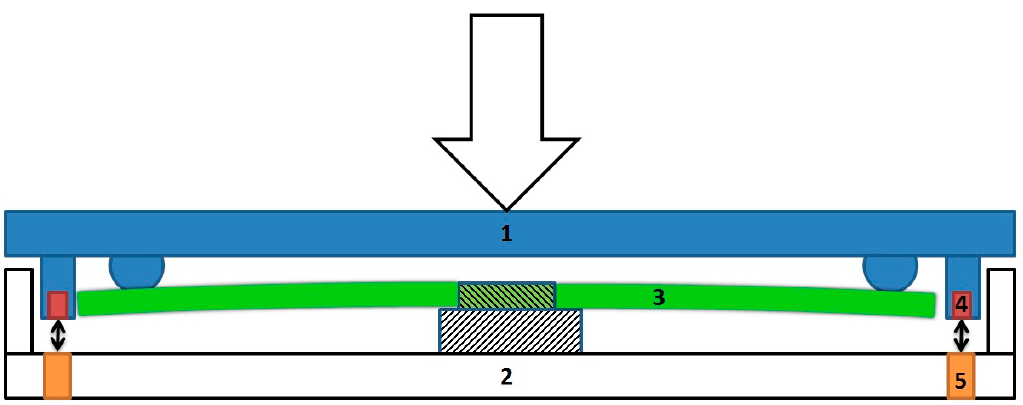
Figure 2. Schematic representation of the sensor. The sensor consists of six different parts: (1) the cover and (2) bottom plate consist of high quality non-ferromagnetic aluminum 7075 (AlZn5,5MgCu), (3) the laser-cut flat spring is made of strong and non-corrosive stainless steel (RVS AISI 301), (4) the N45 magnets are made of NdFeB (Neodymium–Iron–Boron), (5) the Hall sensors (Honeywell SS49E), and (6) a U3-HV USB data acquisition module (LabJack, Lakewood, CO, USA, not shown in figure). A force exerted on the cover plate (1) will be transferred via the beads to the four flat springs (3). Depending on the applied force, these springs will bend more or less, which results in movement of the magnets (4) and thus a change in the magnetic field at each of the Hall sensors (5). This creates changes in the output signal of the Hall sensors, which makes it possible to calculate the total force exerted on the spring by using the correct signal processing and algorithm.